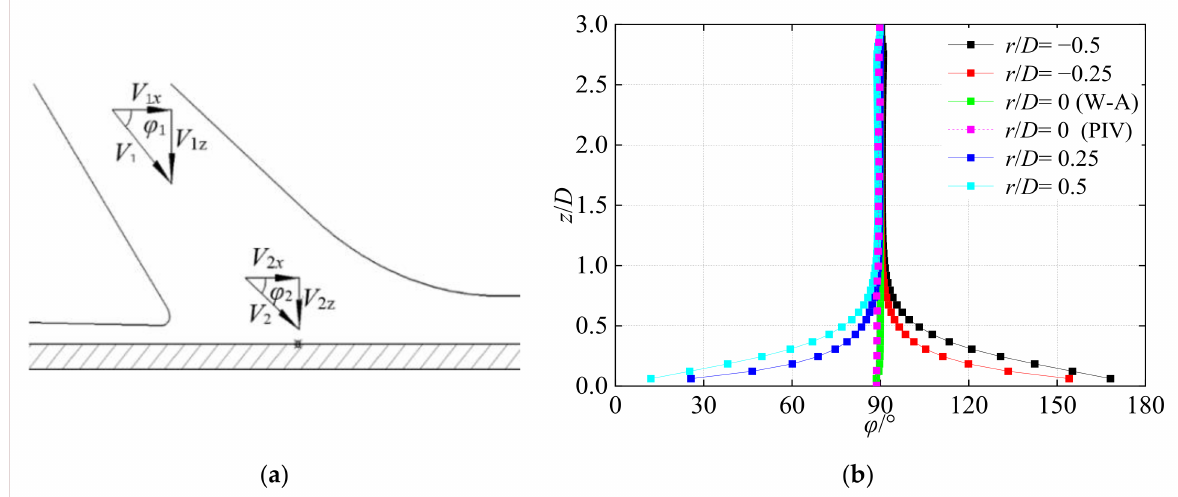
Figure 11. ( a ) Schematic diagram of the flow angle ϕ ; ( b ) the axial distribution of the flow angle ϕ at different radial positions in the cross-section of the jet.